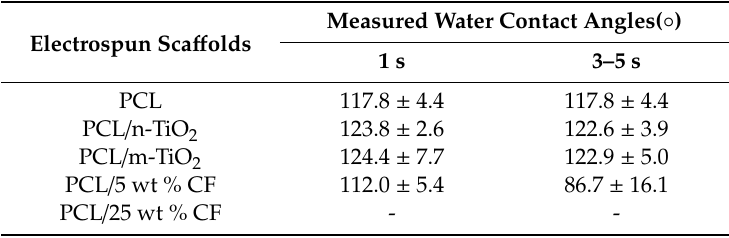
Figure 6. Water contact angle measurement on the surface of the electrospun scaffolds: ( a ) PCL, ( b ) PCL / n-TiO 2 , ( c ) PCL / m-TiO 2 , ( d ) PCL / 5 wt % CF (1 s), ( e ) PCL / 5 wt % CF (5 s), ( f ) PCL / 25 wt % CF. Table 1. Water contact angle measured on the surface of the electrospun scaffolds.